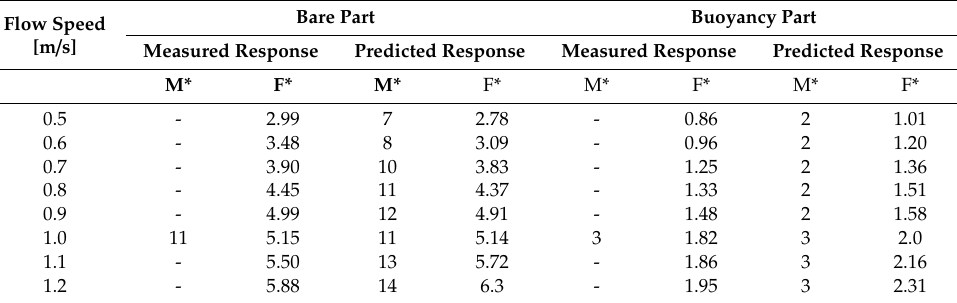
Table 12. Comparison between measured results and predicted response frequencies with an